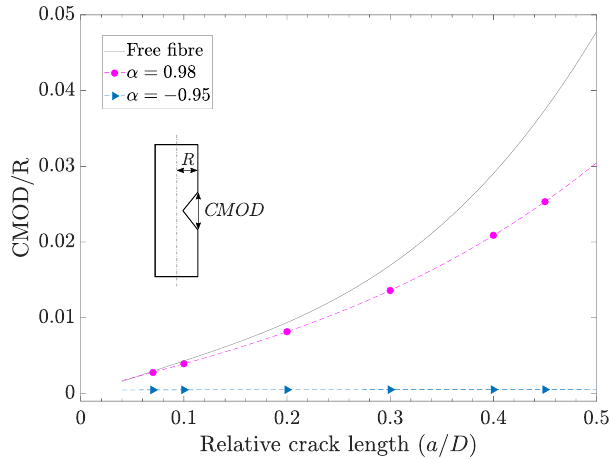
Figure 5. Non-dimensional CMOD for an isotropic fibre embedded in a matrix for different fibre–matrix stiffness ratios, α . The continuous grey curve corresponds to the CMOD for a free fibre ( α =